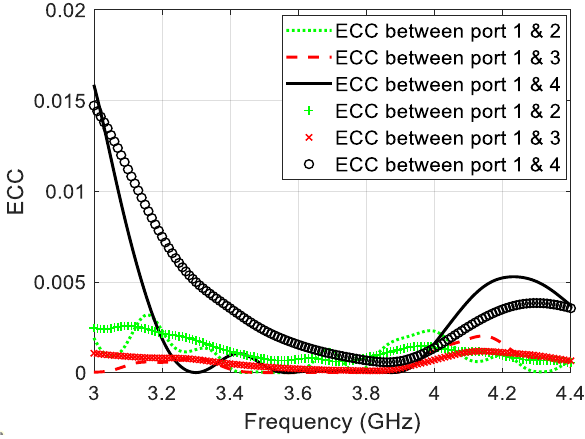
Figure 13. Simulated and measured 𝐸𝐶𝐶 of the proposed MIMO structure.